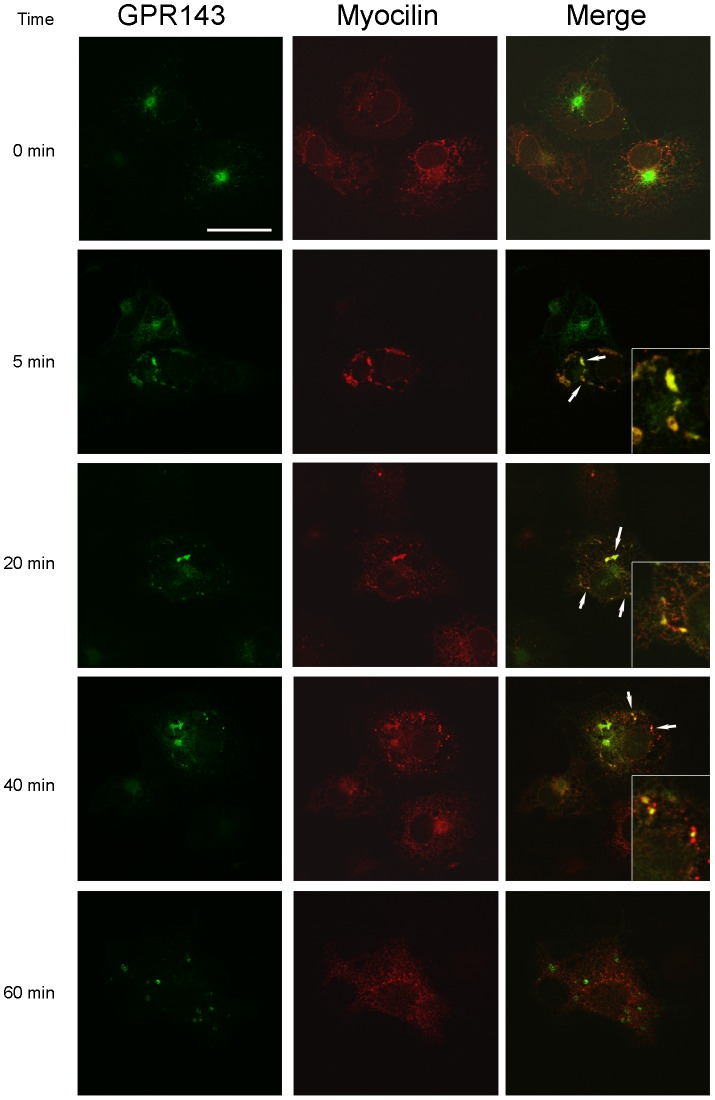
Ligand-dependent co-localization of myocilin and GPR143.Confocal micrographs of GPR143 linked to GFP and myocilin identified by immunofluorescence. Cells were harvested at 0, 5, 20, 40, 60 after exposure to 1 µM l-DOPA. Overlaid images illustrate co-localization of GPR143 and myocilin starting at 5 minutes and continuing through 20 minutes, with little co-localization at 40 minutes and no co-localization at time 0 and 60 minutes. Insets (shown for 5, 20 and 40 min) are 4x computer magnification of a region denoted with an arrow illustrating co-localization. Bar equals 25 µM.